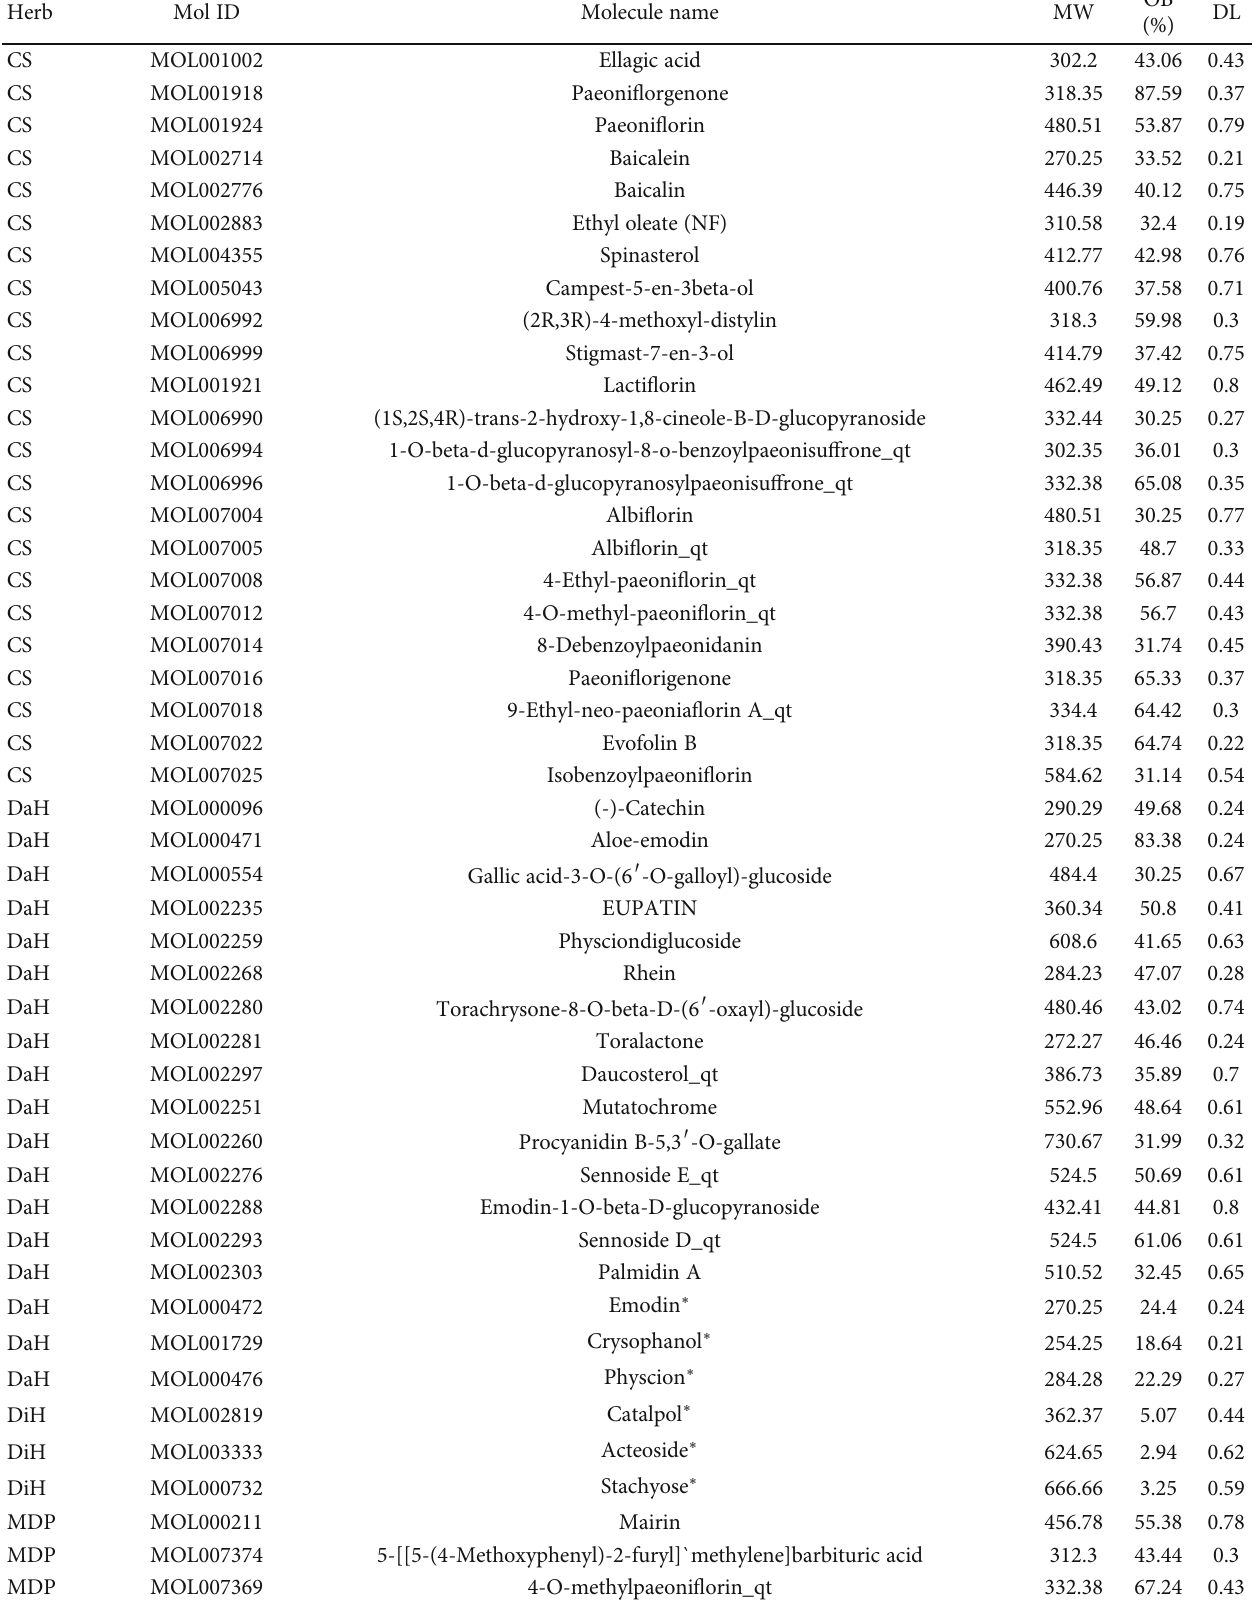
Table 1: Description of ADME parameters of LXTYF active